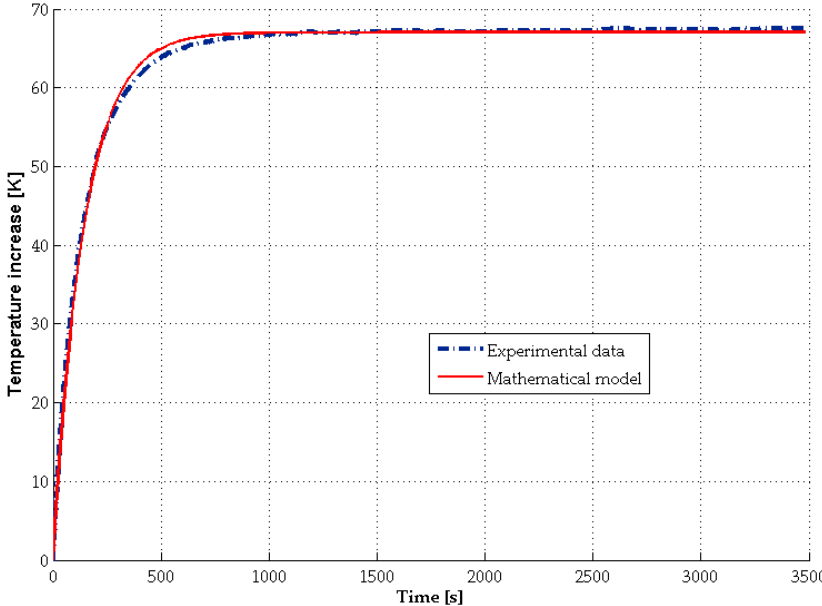
Figure 5. Average surface temperature increase of the panel during the transient testing.